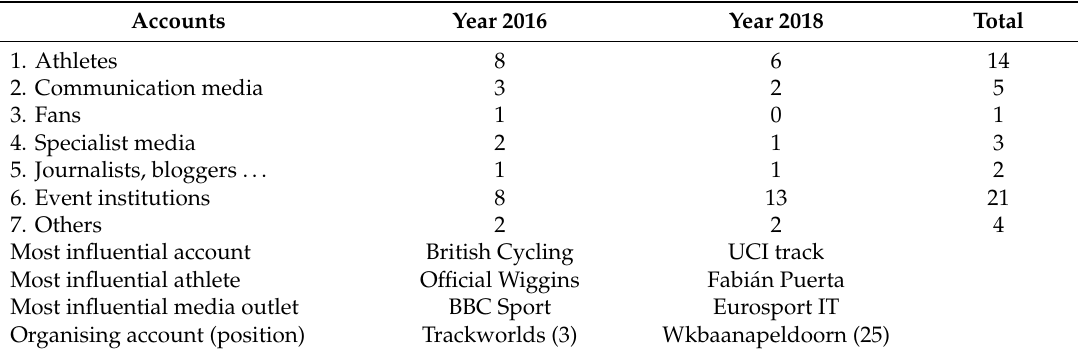
Table 5. Grouping of users by category and event. Source: own